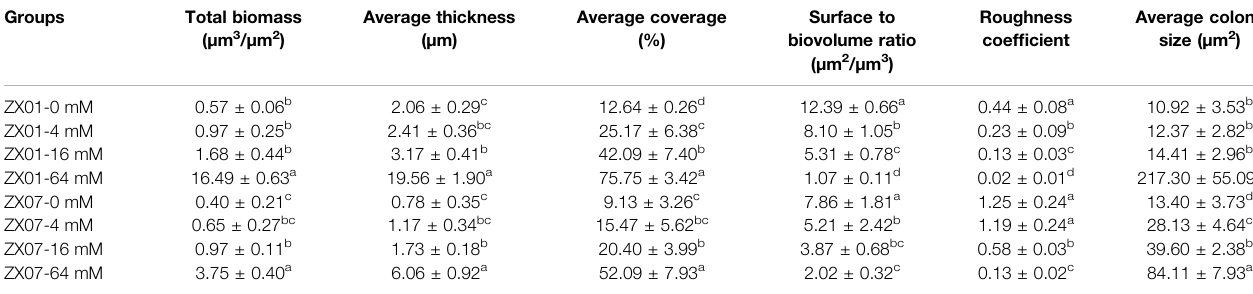
TABLE 1 | Characteristics of bio fi lms formed by ZX01 and ZX07 under different calcium concentrations calculated from the CLSM images using COMSTAT. Groups